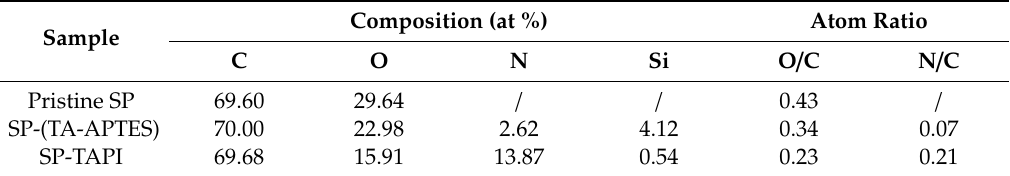
Table 1. Surface element composition of the pristine SP substrate and modified